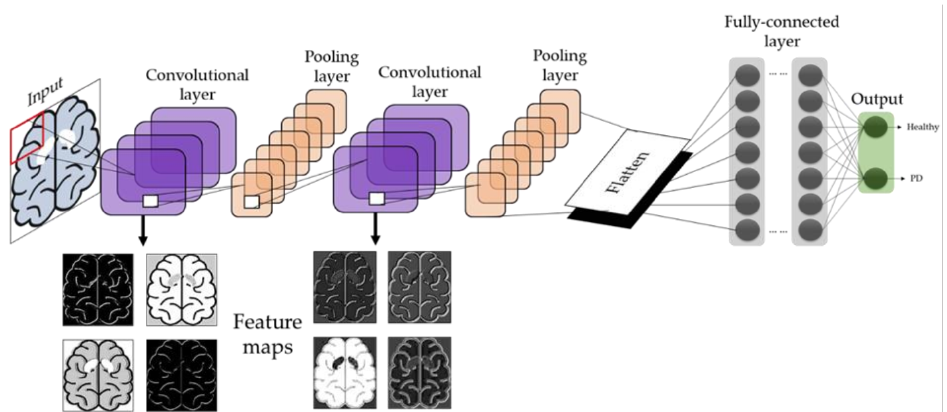
Figure 2. Basic architecture of the CNN